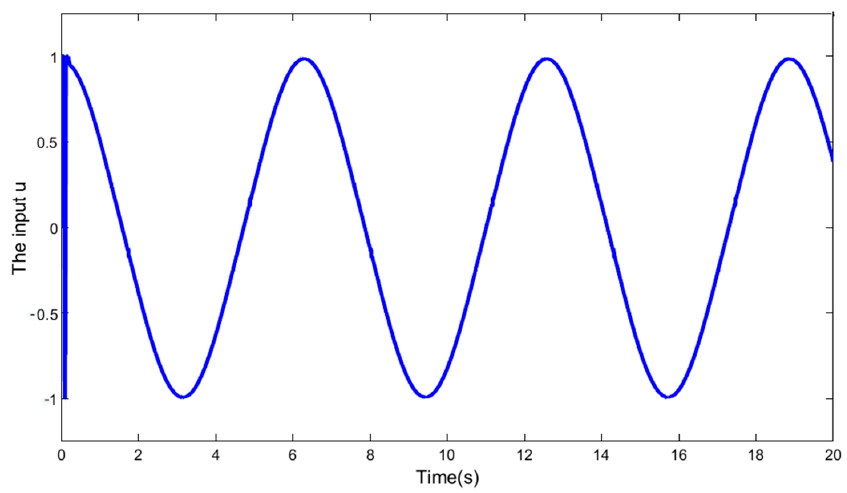
Figure 5. Control input for GSTDO-GSTBSMC u in Experiment 1.